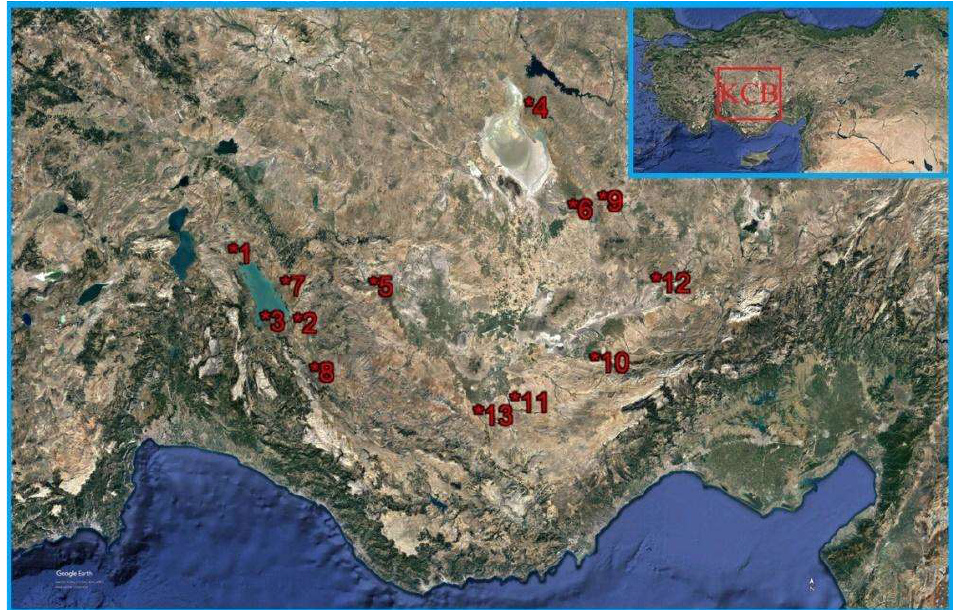
Figure 1. Sampling sites in KCB [station numbers (SN *) given in Table 1; produced by Burçin Aşkım Gümüş by using Google Earth Pro, V 9.171.0.0, 2022].